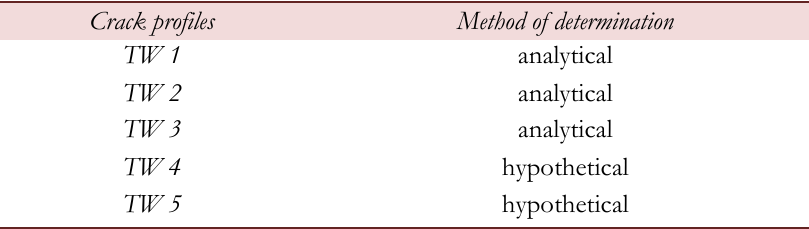
Table 7: Crack-profile labels and estimation technique.